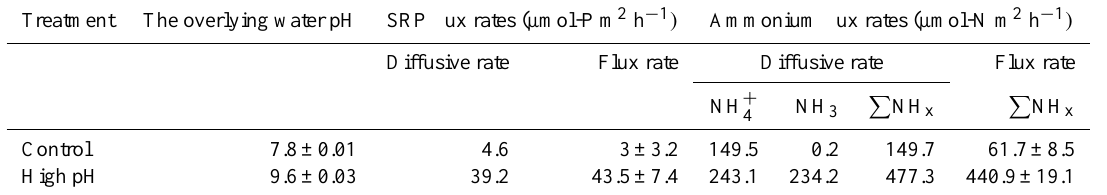
Table 4. Efflux rates of SRP and P NH x in control and in high pH treatments in sediment cores from Powerline. Net flux rates (±SE) were compared to rates estimated from molecular diffusion of pore water. Treatment